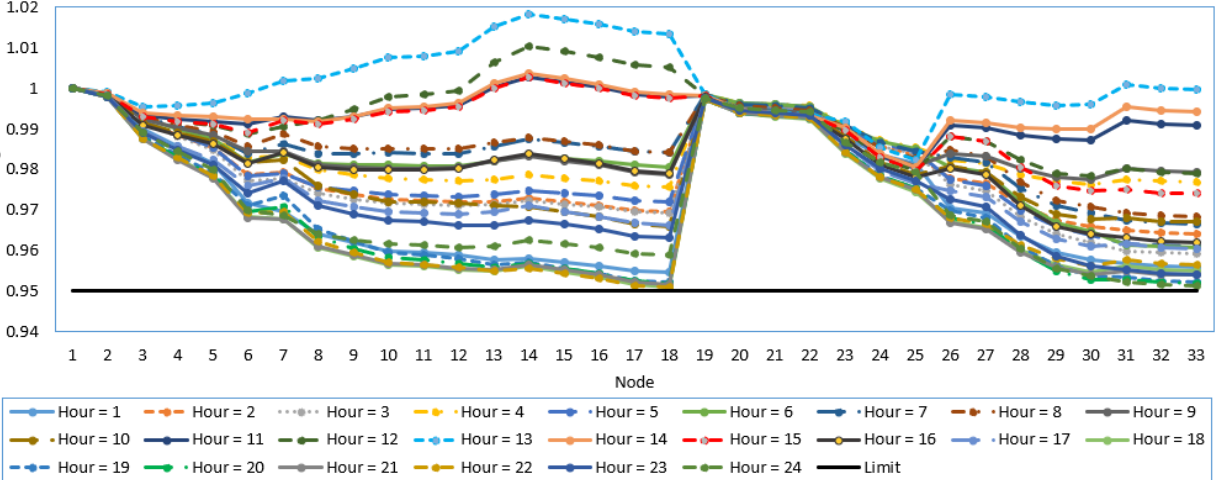
Figure 13. Hourly voltage profile for the third scenario for the IEEE 33-distribution system.